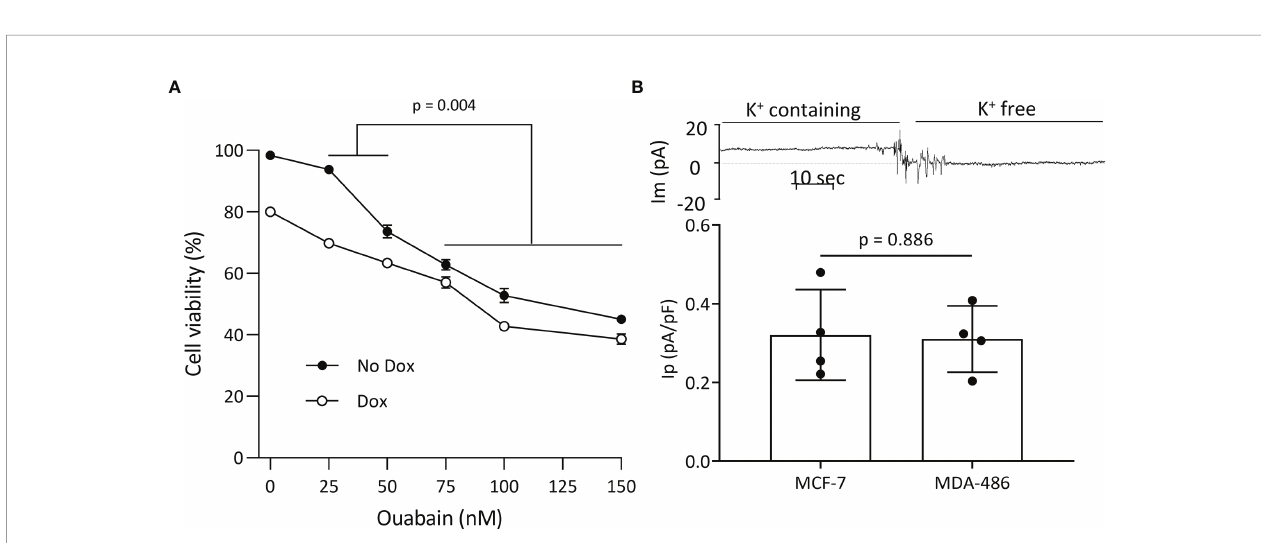
FIGURE 6 | Plasmalemmal Na + /K + -ATPase as a potential target for FXYD3-pep SKSK. (A) MCF-7 cell survival after a 48-h exposure to ouabain in concentrations indicated, with or without co-exposure to 1 m M doxorubicin (Dox). * indicates difference in additive effect of ouabain and Dox at 25 or 50 nM ouabain vs. 70 – 150 nM ouabain. N = 5 for each ouabain concentration. (B) Electrogenic Na + /K + -ATPase pump currents (I p ) of MCF-7 cells that do, and MDA468 cells that do not, overexpress Na + /K + -ATPase. The trace of membrane current (Im) was recorded in an MCF-7 cell before and after Na + -K + pump activity was eliminated with exposure to K + -free extracellular solution. The inward shift to a near-zero holding current in K + -free solution identi fi es I p . Currents were sampled with an electronic cursor after electrical noise caused by extracellular solution change had